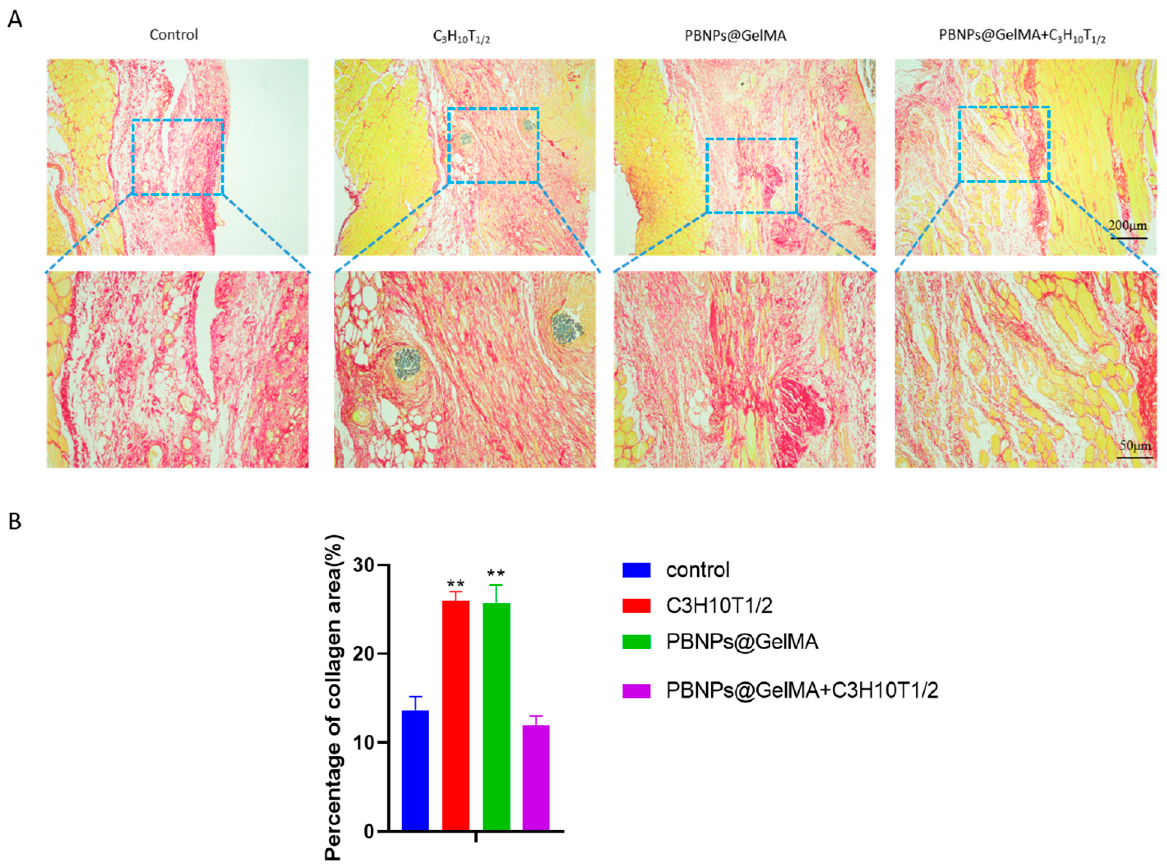
Figure 6. Observation of collagen regeneration with Sirius Red staining in vivo. ( A ) Sirius Red staining images of abdominal wall muscle defect treated with control, MSCs, PBNP@GelMA, and MSCs + PBNP@GelMA 2 weeks after surgery. ( B ) Statistics of percentage of collagen deposited after treatment ( n = 3). Samples without implants were used as a control group; ** p < 0.01.